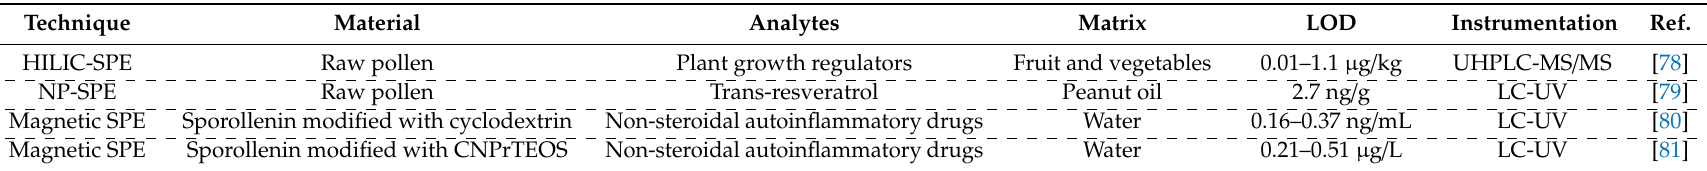
Table 3. Applications of pollen as sorbent material in microextraction techniques for di ff erent analytes and matrices. (Reference period: